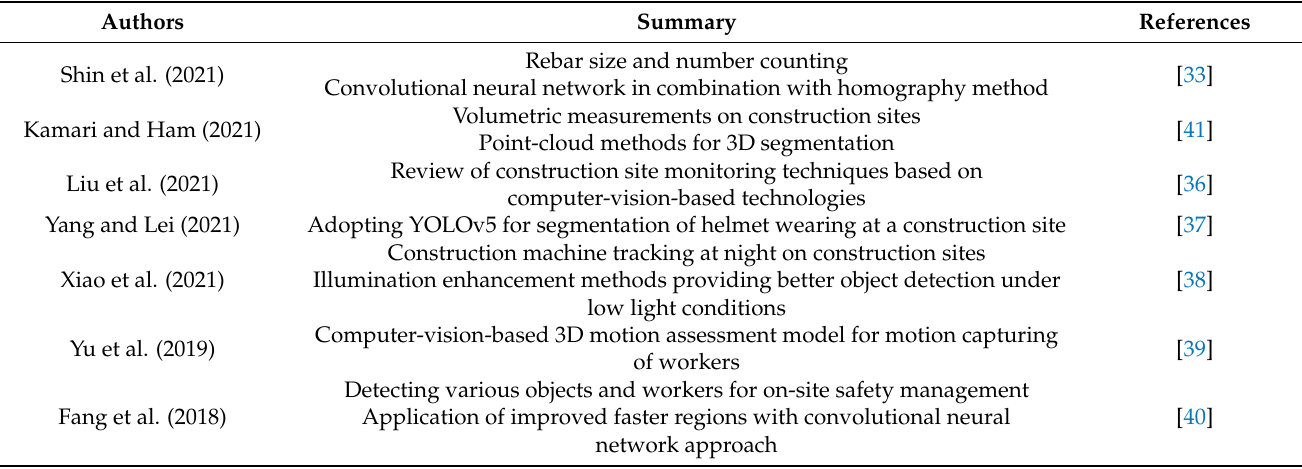
Table 1. AI studies on construction site